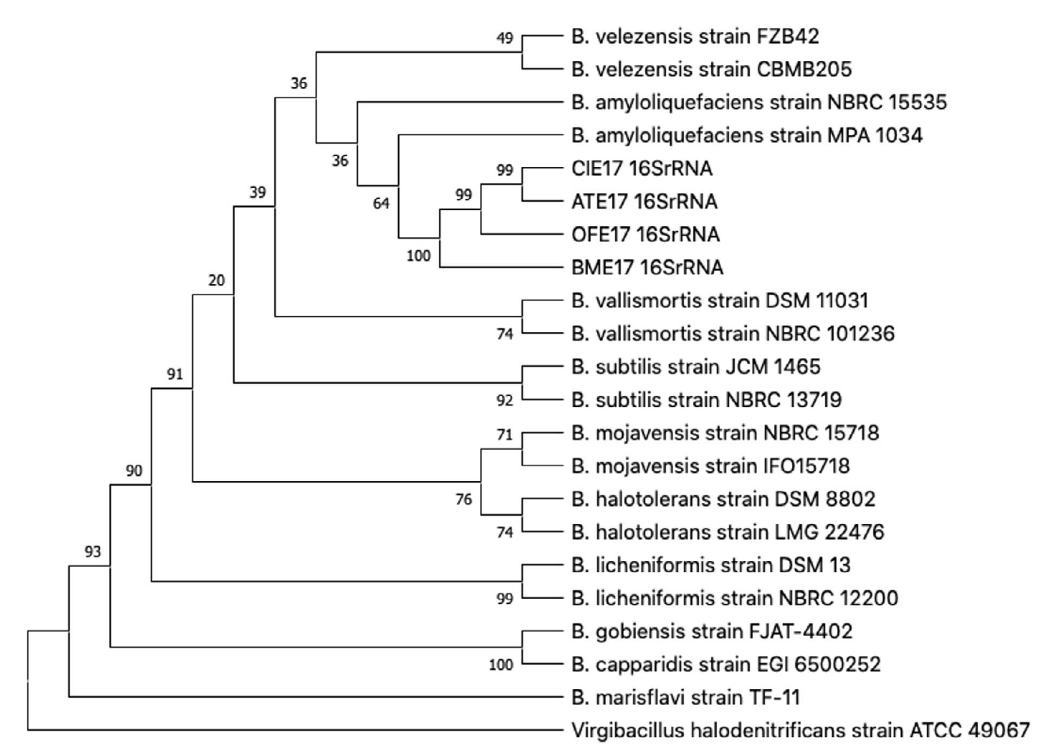
Fig. 3. Phylogenetic tree based on Neighbor-joining tree of 22 16S-rRNA gene partial